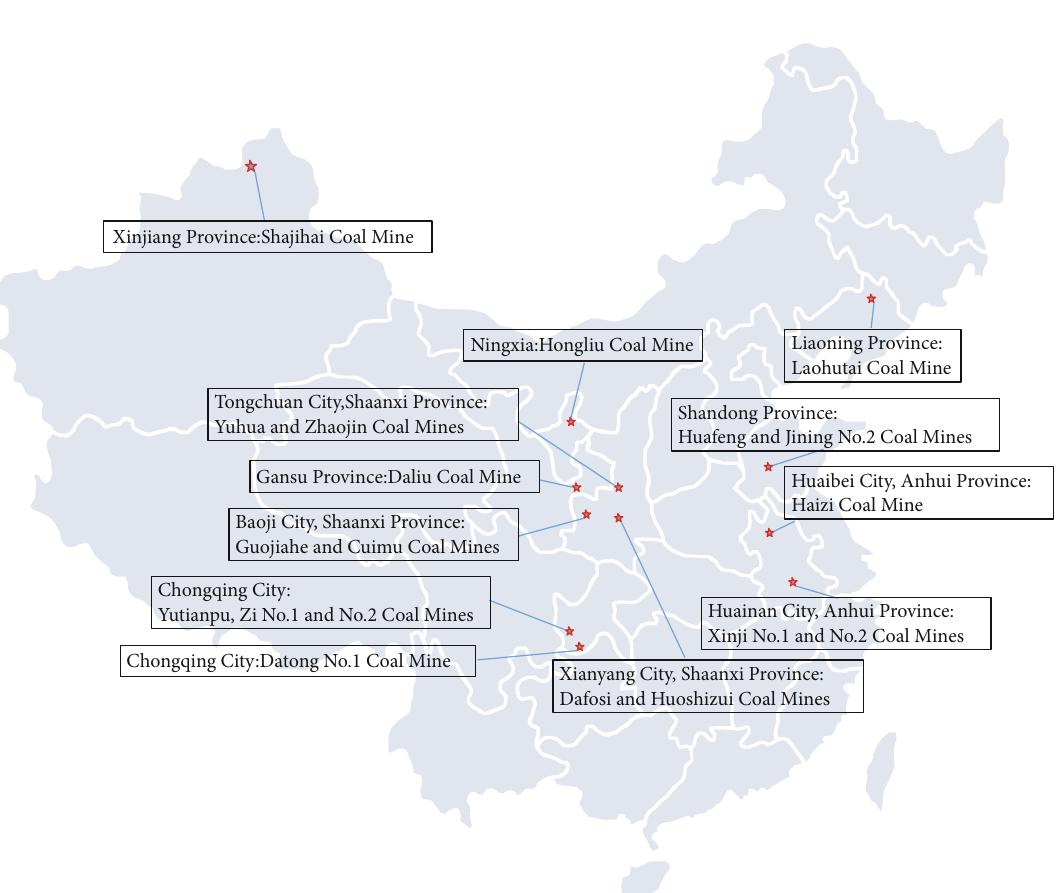
Figure 2: Distribution of bed separation water inrush accidents in